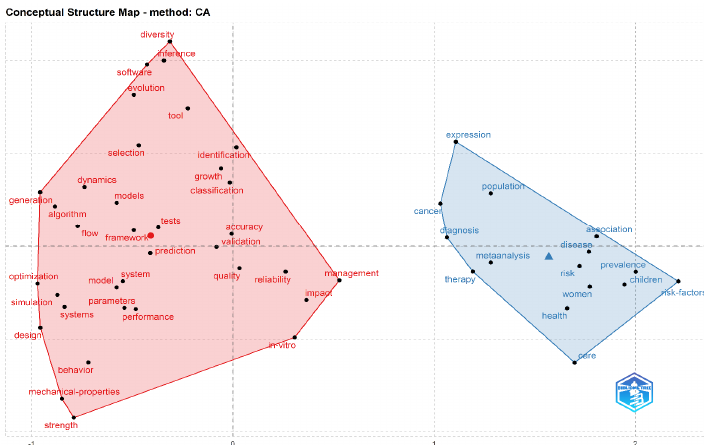
Figure 18. Conceptual Structure Map representing clusters of research themes on the basis of corre- spondence analysis for the years 2016–2018.